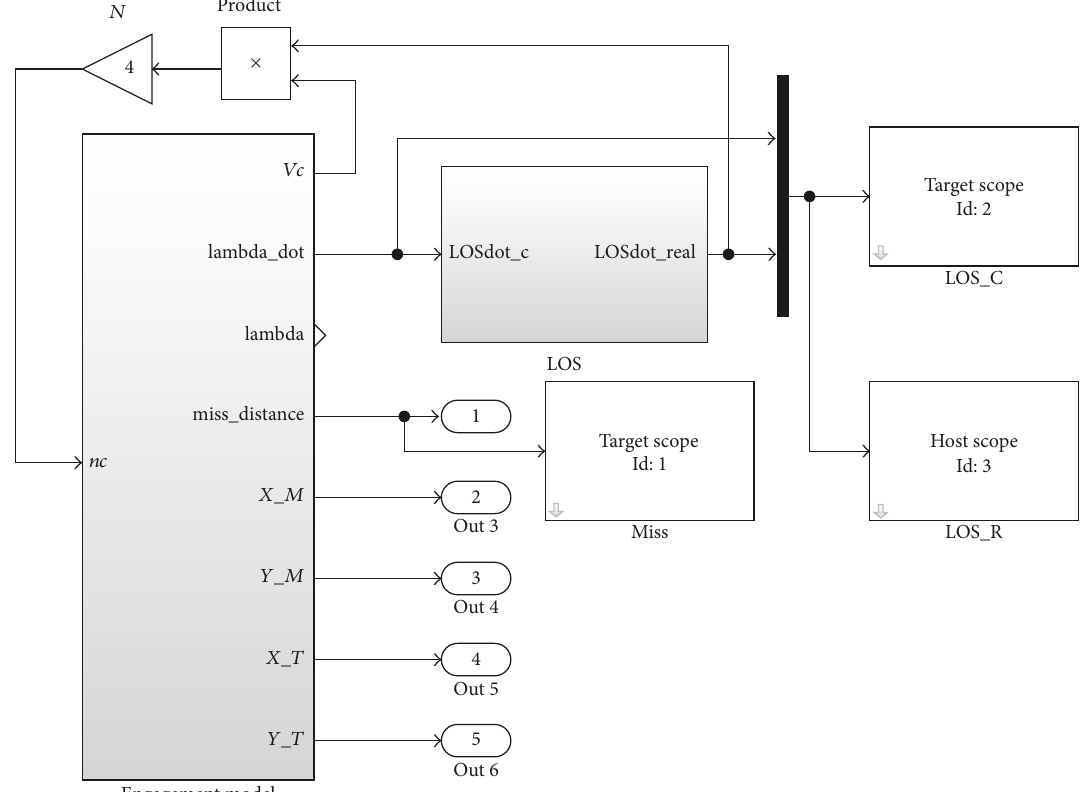
Figure 7: Simulation model built on the